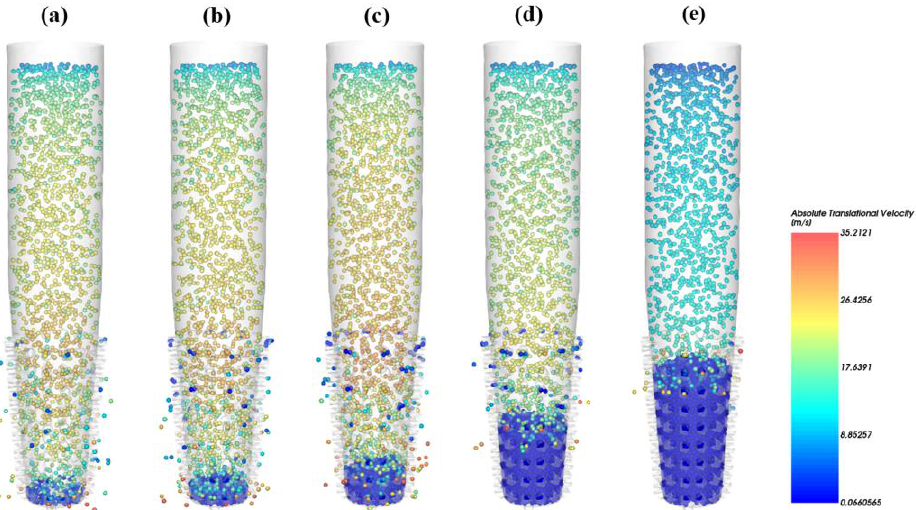
Figure 9. Displacement and retention behavior of LCMs in mud screen, (a)~(e): behavior changes with mud injection time.